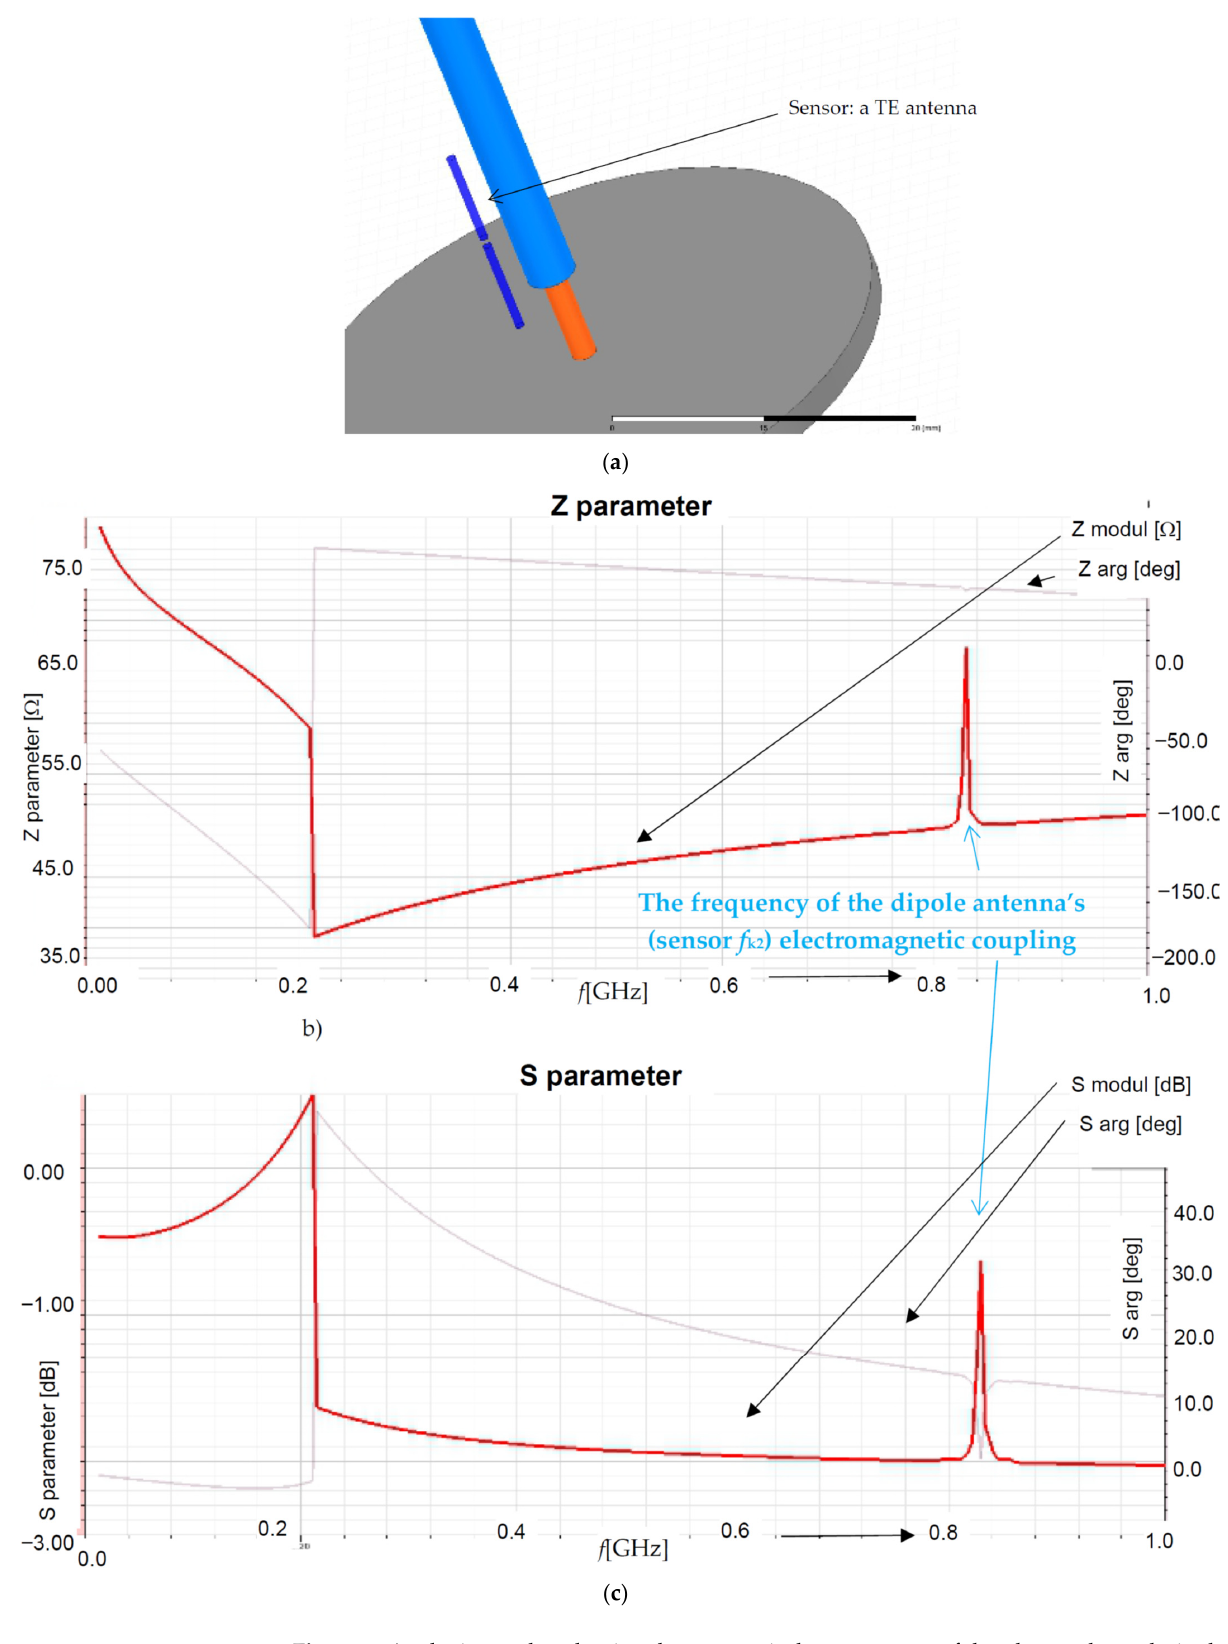
Figure 5. Analyzing and evaluating the geometrical arrangement of the plasma channel, single-turn electrode, external medium, bottom metal plate, and antenna: ( a ) the geometrical model with the sensing antenna TE; ( b ) parameter z 11mod , f = 10 MHz–1 GHz; ( c ) parameter z 11arg , f = 10 MHz–1